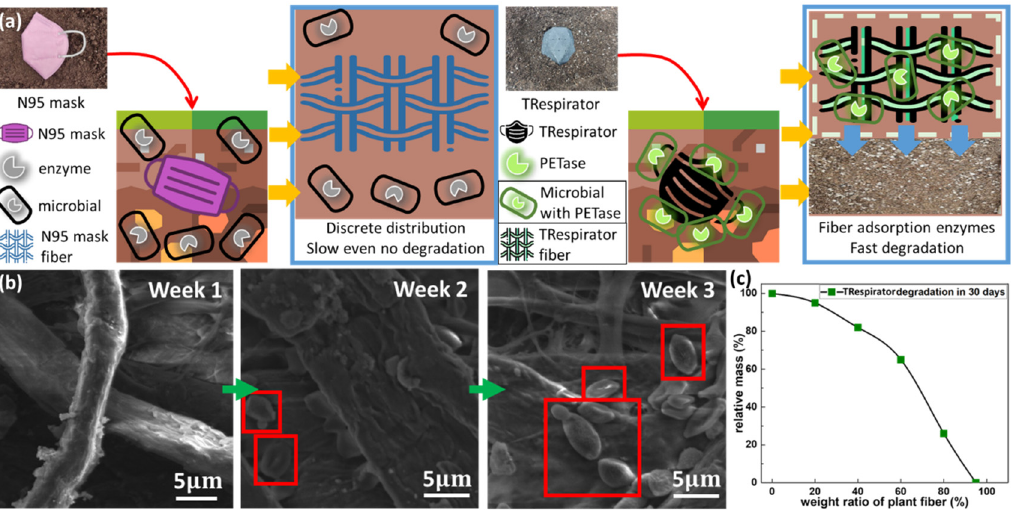
Figure 4. The degradation mechanism of the plant-fiber-plastic system in the TRespirator ( a ) The degradation mechanism of an N95 mask and TRespirator, ( b ) SEM images of degrading TRespirator samples from week 1 to week 3, ( c ) image about the degradation effect in 30 days with a different weight ratio of plant fibers.